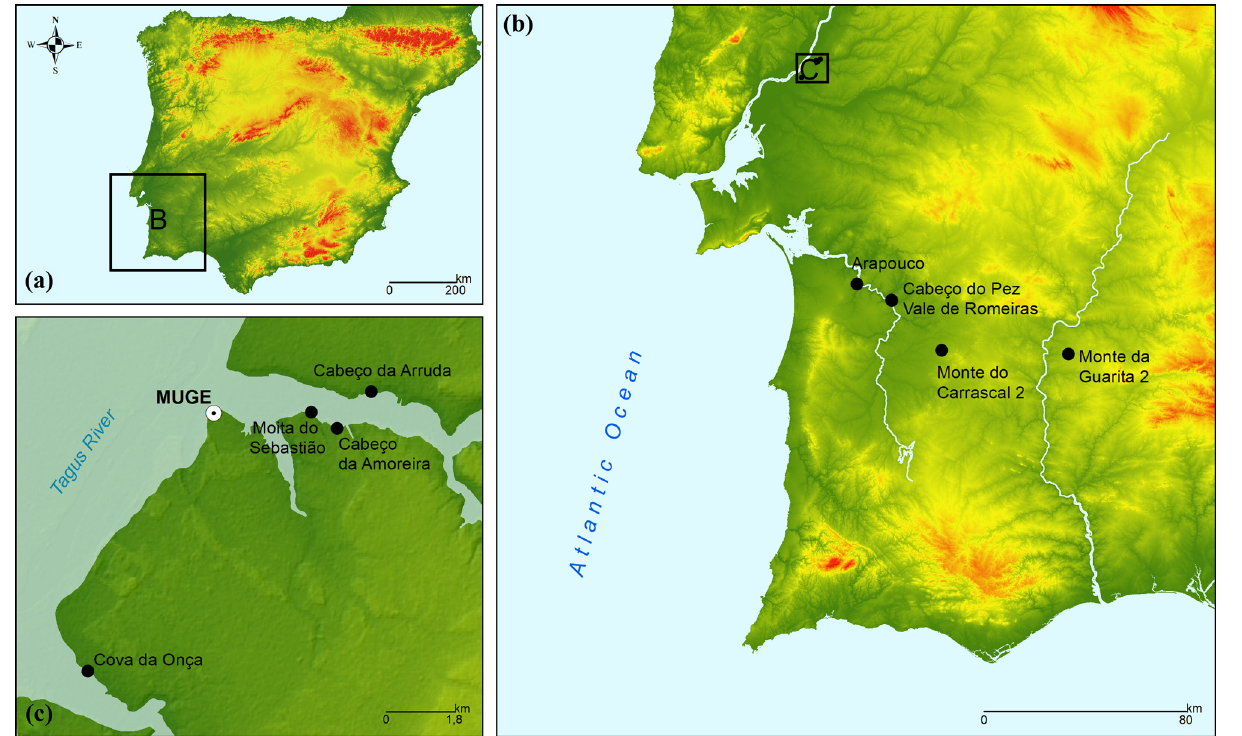
Figure 1: Location of the archaeological sites from which the specimens used in this study were recovered. ( a ) Overall location of sites within Iberia. ( b ) Cluster location of the Muge shell - middens and individual location of the remaining sites. ( c ) Individual location of each of the Muge